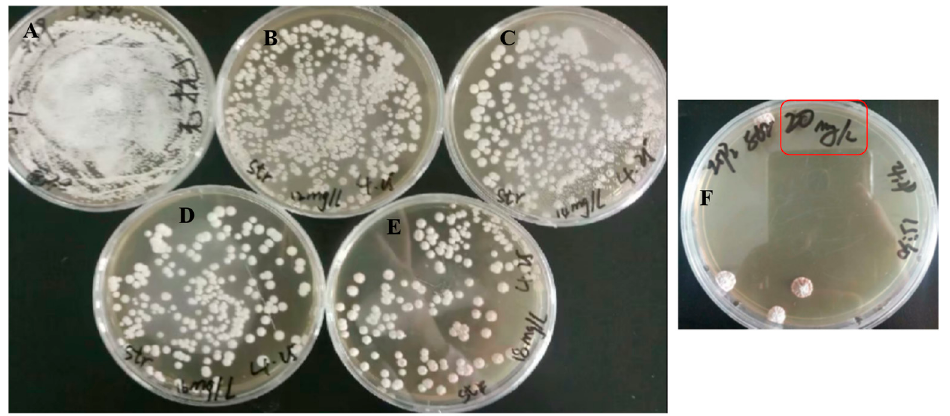
Figure 2. The MIC determination of streptomycin against Actinomadura sp. ATCC 39365. Different doses of streptomycin were added to the agar plates; the concentrations of streptomycin in plates ( A – F ) are 0, 12, 14, 16, 18 and 20 mg/L, respectively. ISP2 plates containing 20 mg/L streptomycin (1xMIC) were used for the isolation of high-yield pentostatin mutants after ARTP mutagenesis. The mutants derived from streptomycin resistance screening after being cultivated on streptomycin-containing plates at different concentrations for 5–7 days are shown in Figure 3. Then, 100 relatively large ARTP mutant clones were selected to evaluate pentostatin production by cultivation in shake flasks, and 16 positive mutants showed higher pentostatin production than the original strain Actinomadura sp. ATCC 39365. Among them, the mutant Actinomadura sp. S-15 with the highest pentostatin production was chosen as being representative.